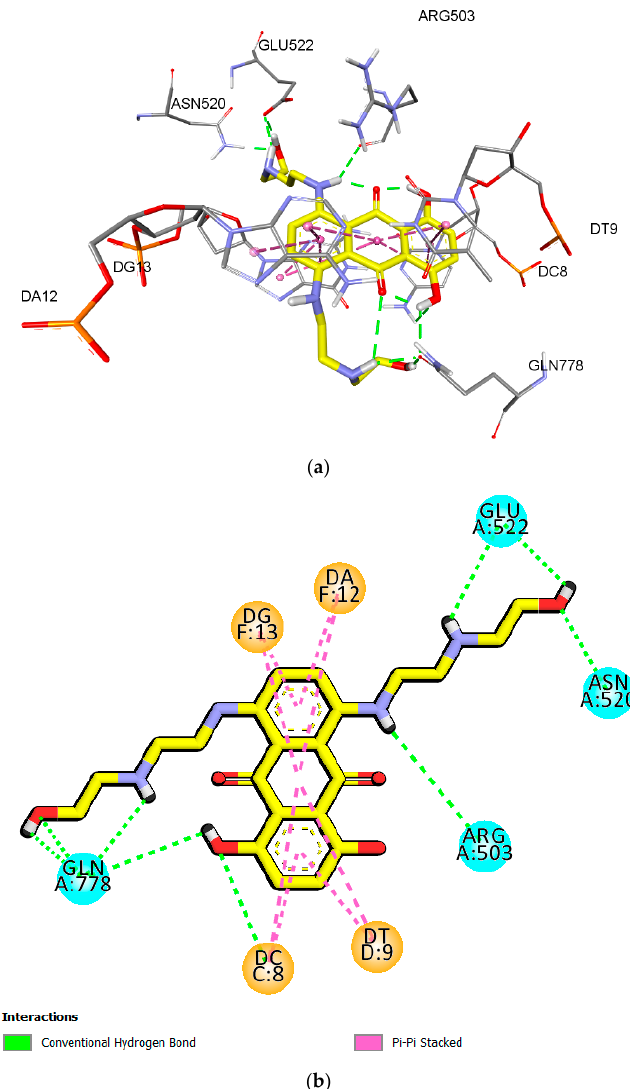
Figure 1. Docking of known inhibitors in topoisomerase II β -DNA complex binding site. Mitoxantrone: ( a ) spatial conformation, ( b ) interaction diagram. Noncovalent interactions of molecule are shown by dotted lines: green—hydrogen bonds, purple—stacking interactions. Nucleotides are indicated by orange spheres, amino acid residues of topoisomerase are indicated by blue